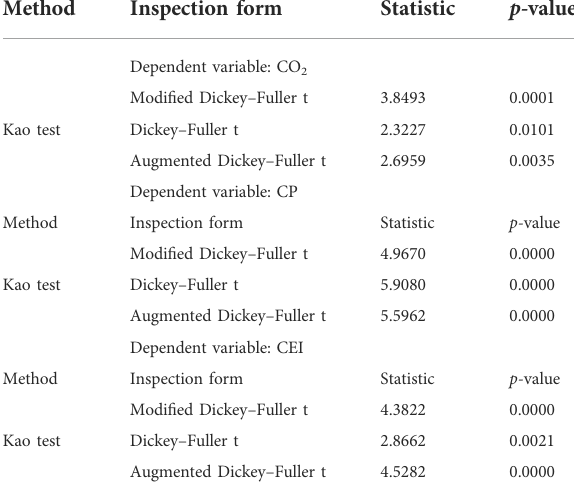
TABLE 5 Cointegration test.